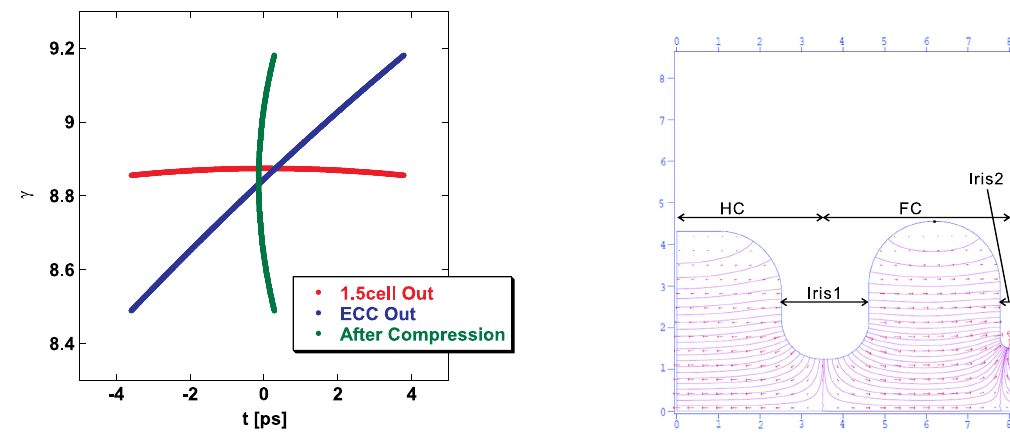
FIG. 6 (color online). Profile of an ECC-rf gun. ECC is added to a conventional rf gun shape. The parts, half cell (HC), full cell (FC), ECC, iris 1, and iris 2, are